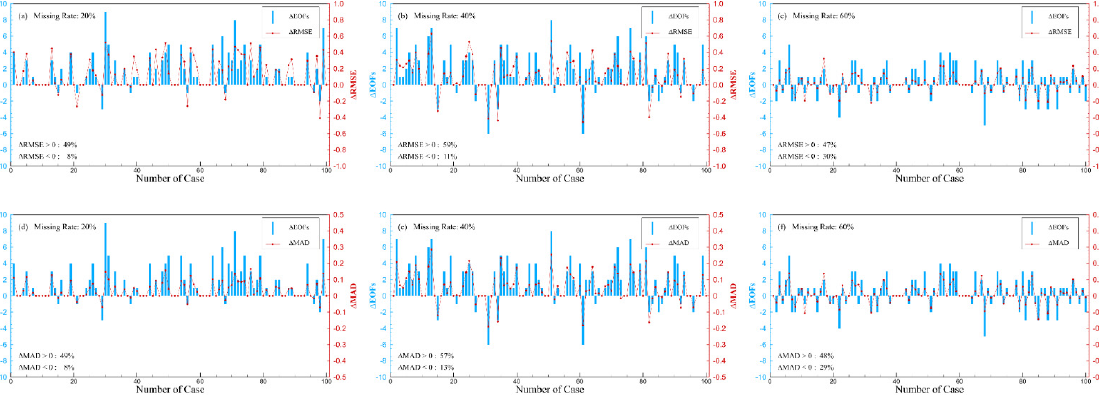
Figure 11. The differences of RMSE and MAD ( a , d missing rate: 20%; b , e missing rate: 40%; and c , f missing rate: